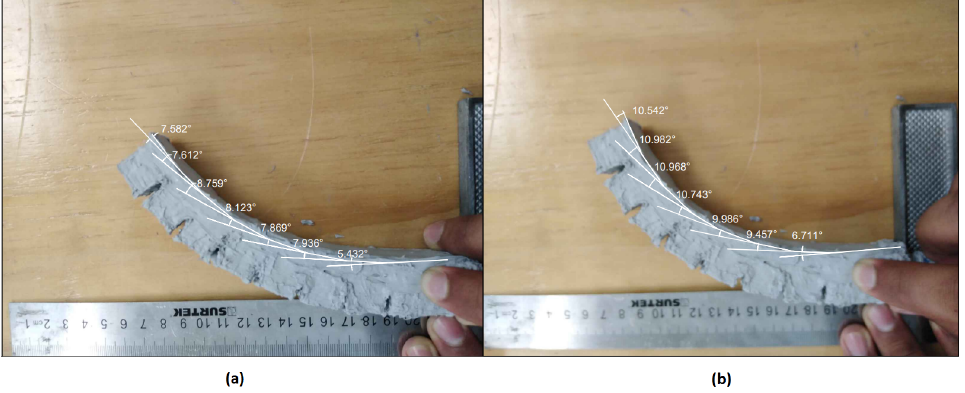
Figure 13. Test measurements of soft actuator flexion at different pressures. ( a ) Tested Displacement at 1.5 kg/cm 2 . ( b ) Tested Displacement at 2 kg/cm 2 .